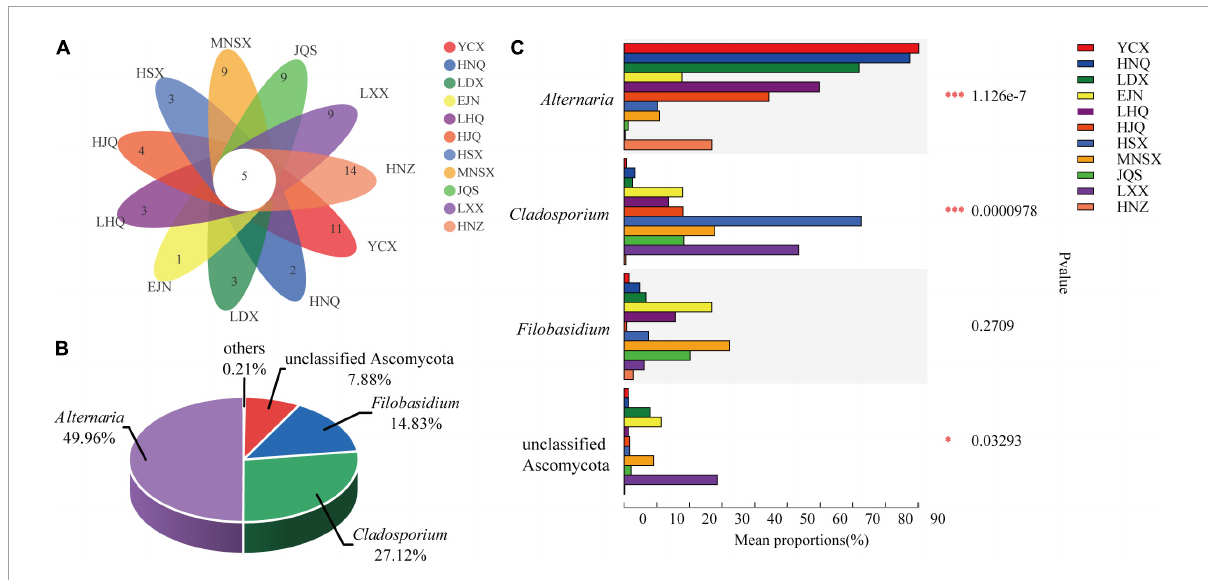
FIGURE4 Species composition and difference test of endophytic fungal community in S. alopecuroides. (A) Venn plot based on genus level representing common or unique genera in the given population. (B) The percentage of core-shared genera. (C) Difference test between groups, the Y -axis represents the species name under a certain taxonomic level, the X -axis represents the average relative abundance of species in different groups, and the columns with different colors represent different groups. The far right is the P -value (one-way ANOVA, * P < 0.05, *** P < 0.001).